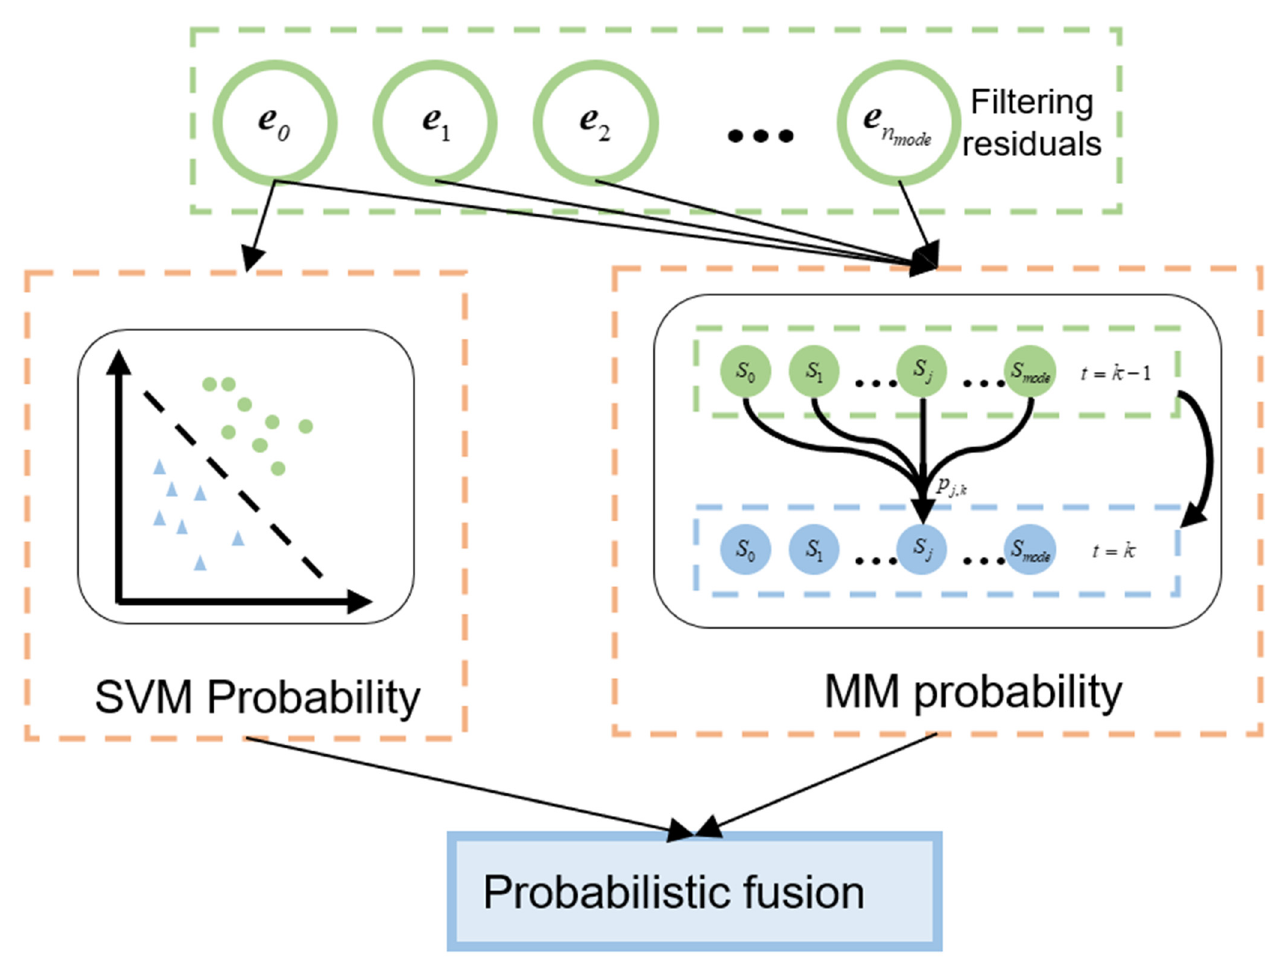
Figure 3. Process of probability fusion.